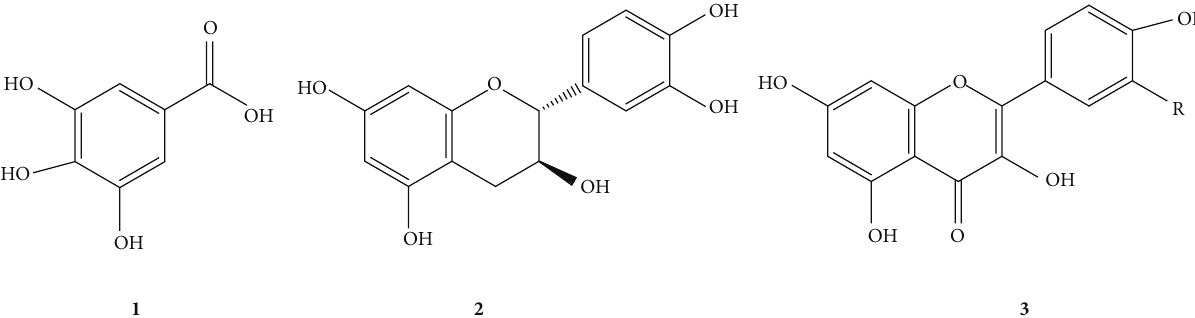
Figure 3: Representative structures of identified polyphenols. ( 1 ) Gallic acid; ( 2 ) Catechin. ( 3 ) The aglycone of compound 3 – 10 : quercetin (R=OH) and kaempferol (R=H). Sugar moieties are usually attached at position 3.